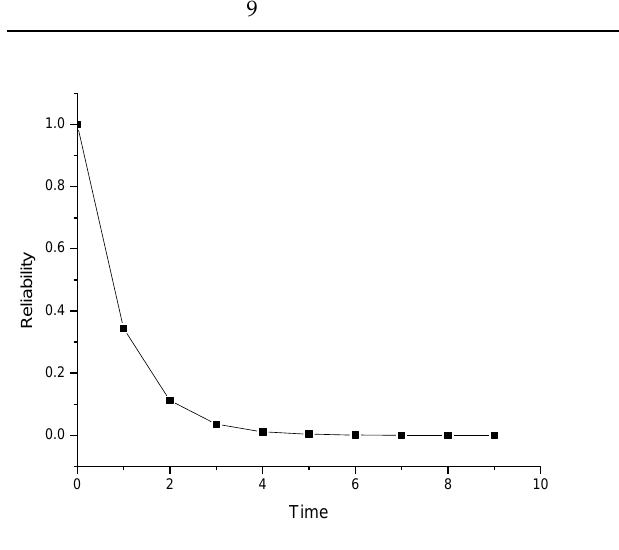
Figure 2. Time vs. Figure 2. Time vs. Reliability.